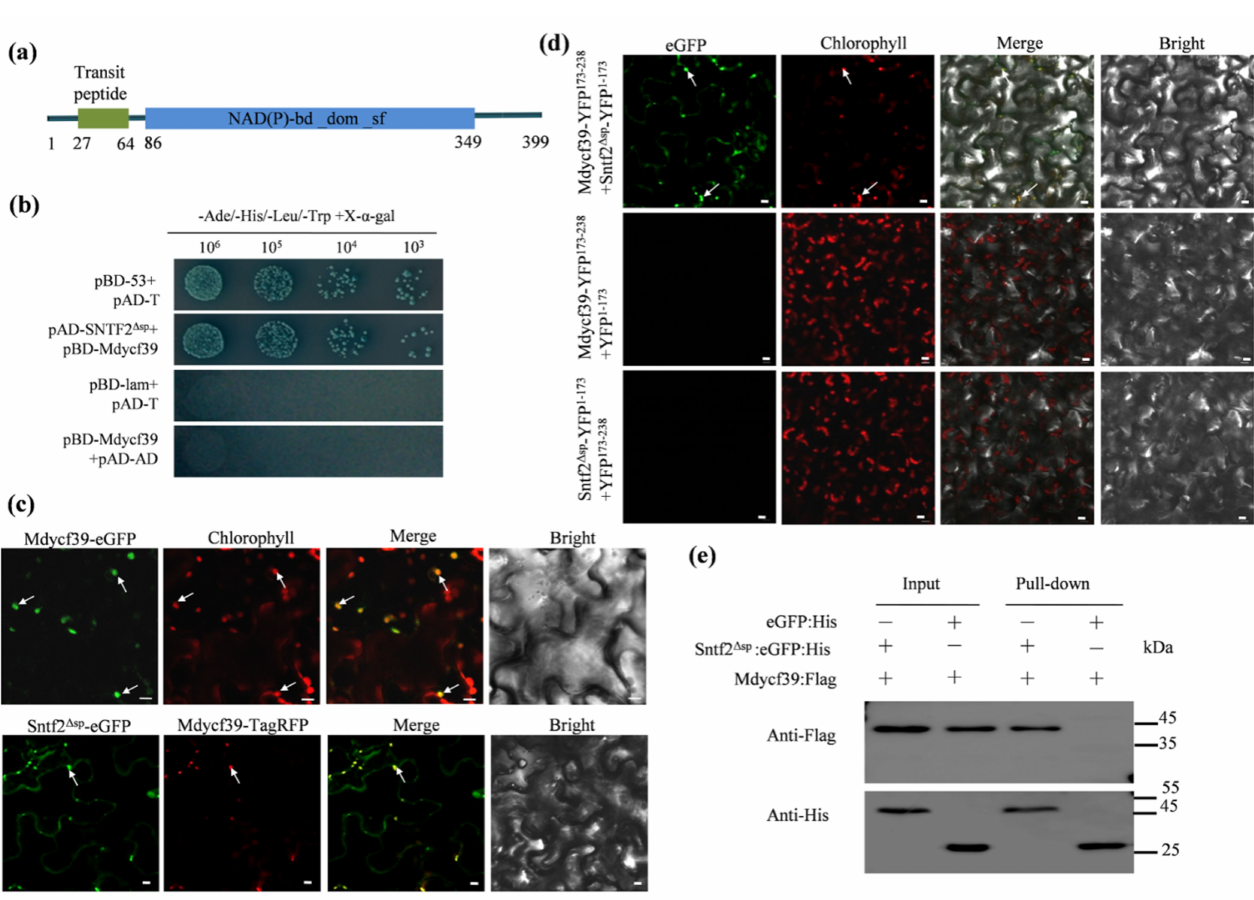
Figure 7. Sntf2 interacted with Mdycf39 in chloroplasts. ( a ) Mdycf39 was predicted to contain a chloroplast-targeting transit peptide and a NAD(P)-binding domain by the LOCALIZER program and InterPro 85.0. ( b ) Confirmation of the Sntf2–Mdycf39 interaction using yeast two-hybrid assays. ( c , d ) Detection of the Sntf2–Mdycf39 interaction using co-localization and bimolecular fluorescence complementation assays. The arrows refer to the chloroplasts. Bar: 10 µ m. ( e ) Confirmation of Sntf2–Mdycf39 interaction using pull-down assays. Western blots for the analysis of Sntf2:eGFP:His and Mdycf39:Flag purified proteins from Escherichia coli M15 and proteins from the His purification column using anti-His and anti-Flag antibodies. The Sntf2 ∆ sp :eGFP:His and Mdycf39:Flag bands were 46 and 45 kDa, respectively. The protein marker is labeled on the